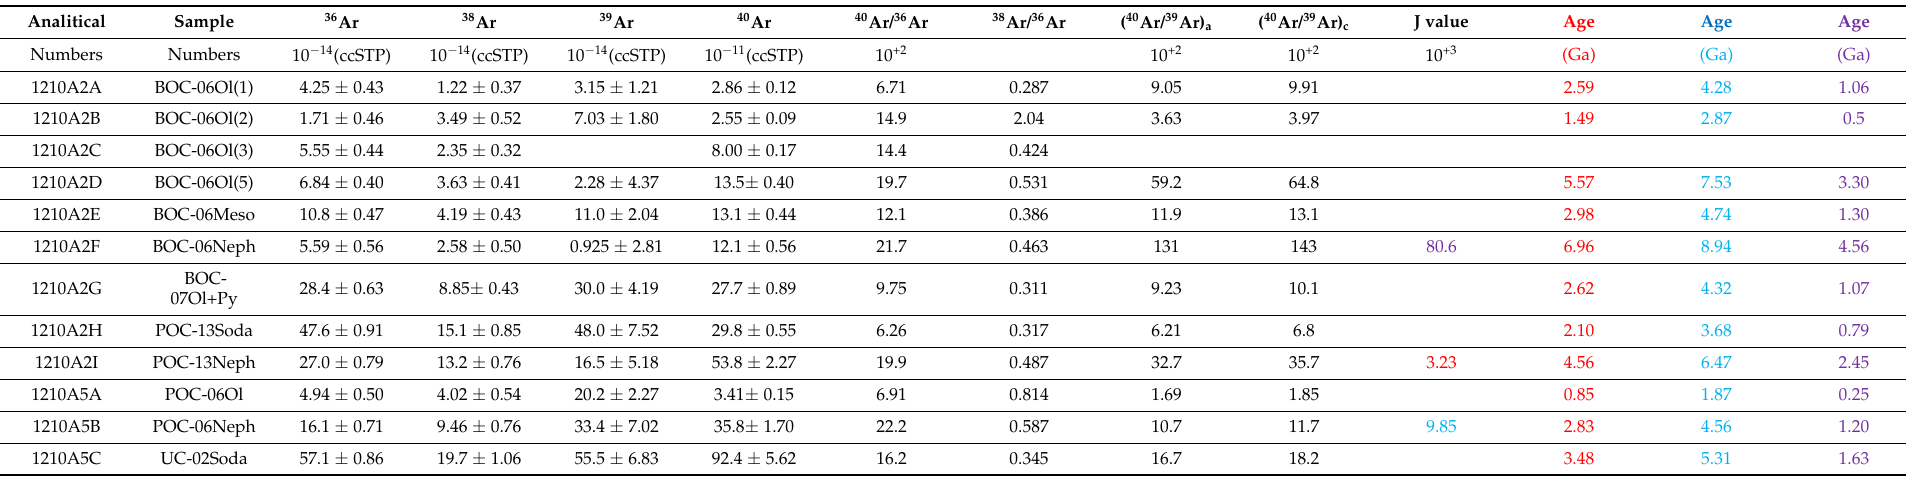
Table 2. In situ argon isotope data of minerals in the investigated chondrules of the Allende meteorite. The number in parentheses after the sample name indicates the total number of laser spots. The abbreviations of olivine, pyroxene, nepheline, sodalite, and mesostasis are Ol, Py, Neph, Soda, and Meso, respectively. See the later Section 6 for the meaning of ( 40 Ar/ 39 Ar) analyzed , ( 40 Ar/ 39 Ar) corrected , J values, and ages (text colors in red, blue, and purple). All error values represent 1 σ